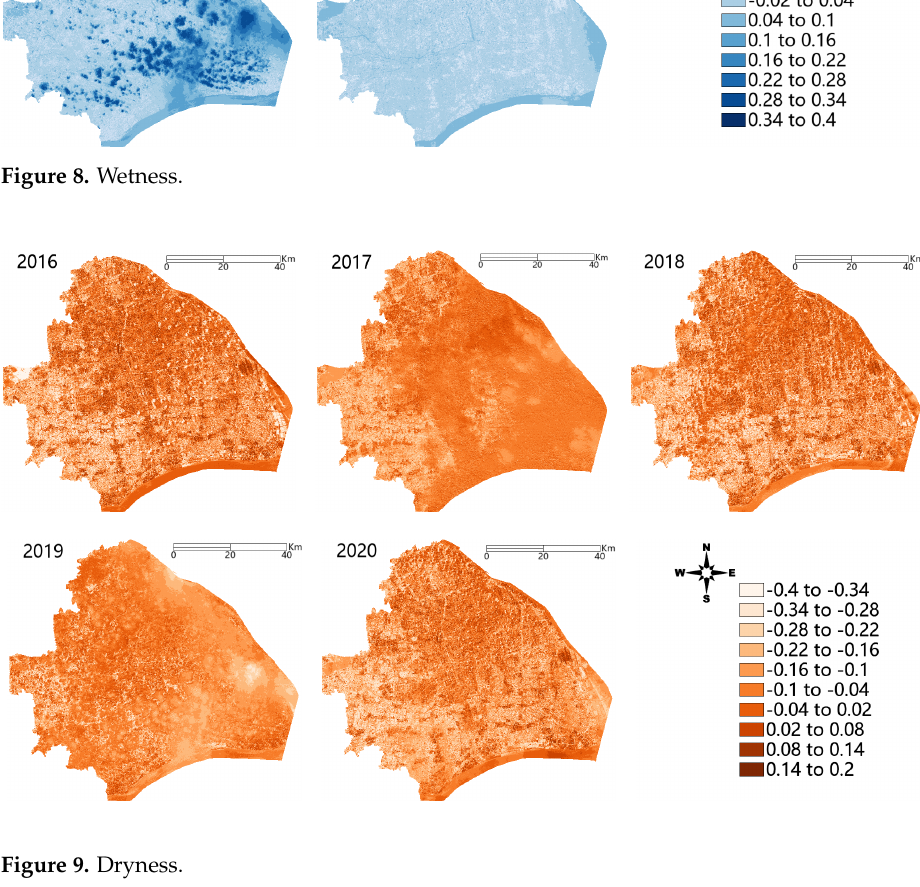
Figure 9. Dryness.